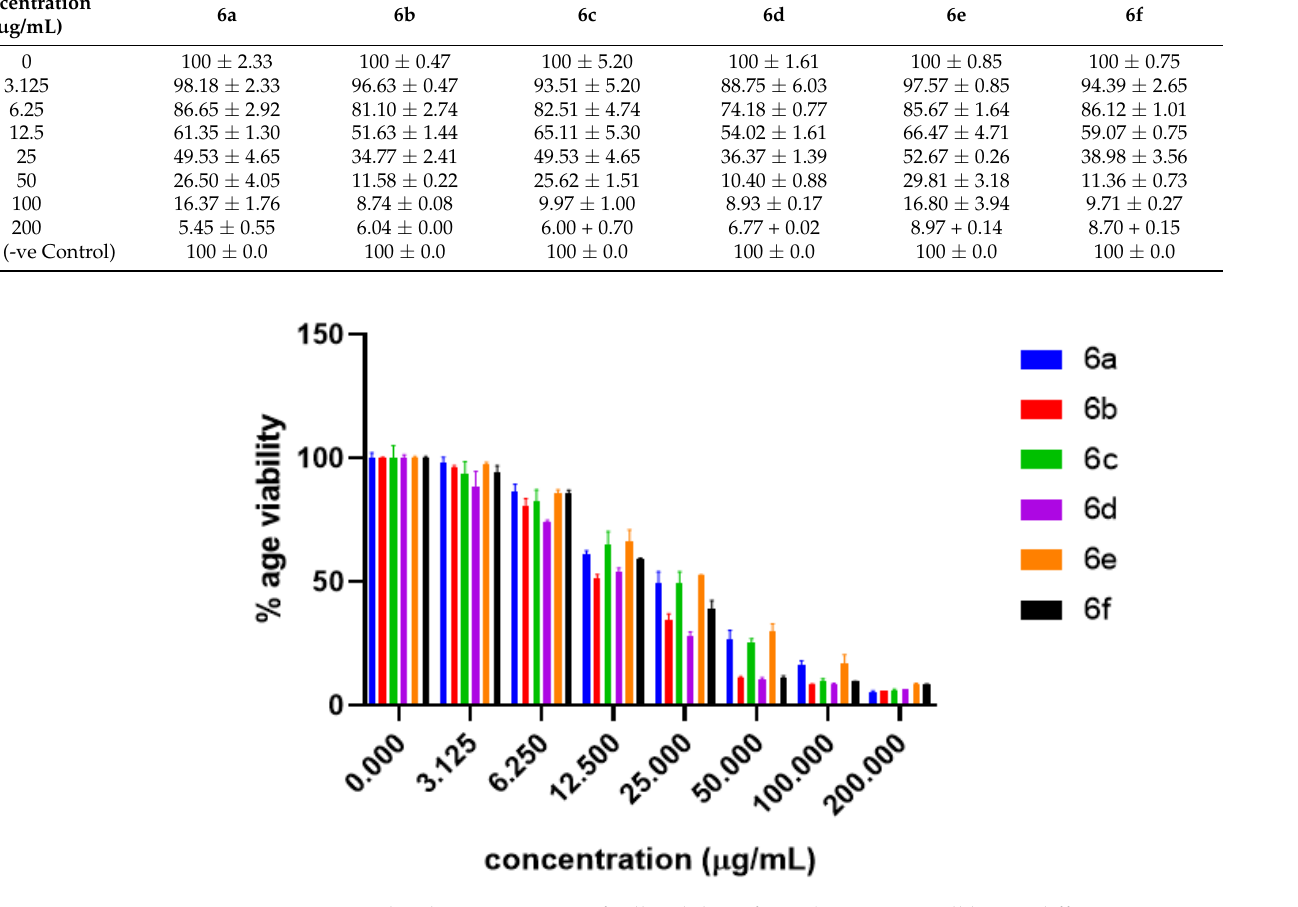
Figure 2. Graphical representation of cell viability of 6a–6f in Hep G2 cell line at different concen- trations by using MTT